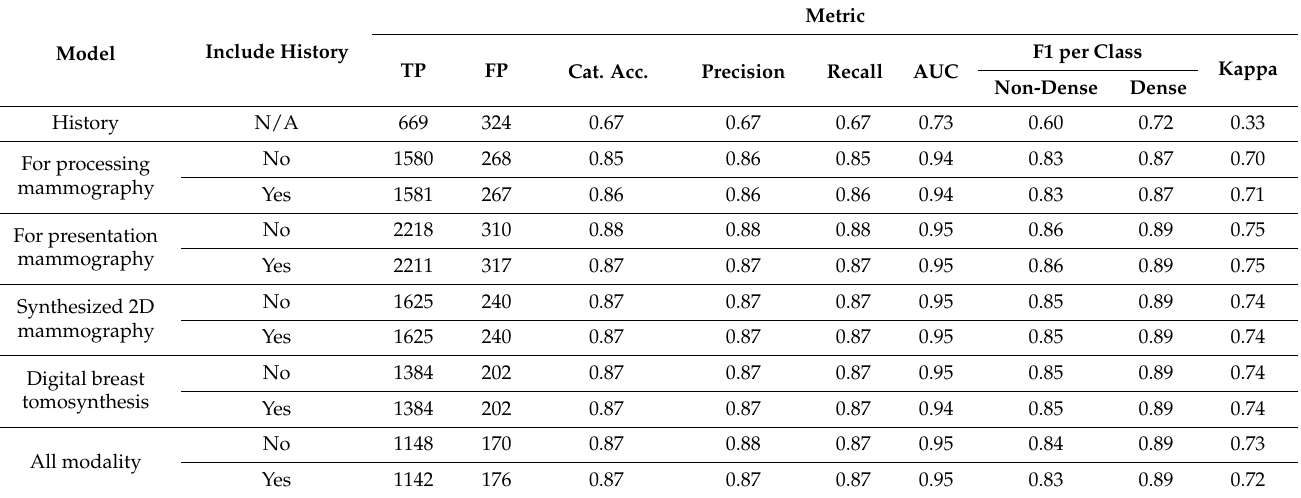
Table 2. Model accuracy on their respective test dataset for all screening years for 2 categories (Non-dense and